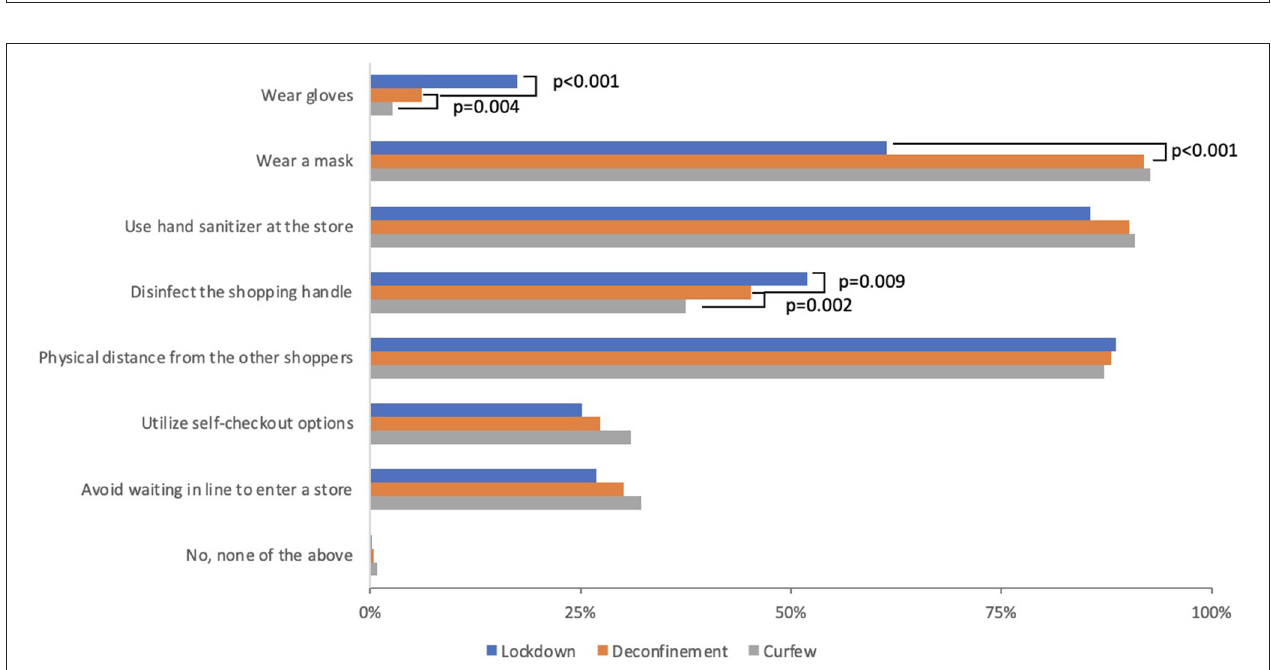
FIGURE 3 | Concerns over in-store grocery shopping. “Between (time period) , which of the following statements describes how you felt about possible exposure to the COVID-19 virus when in-store grocery shopping?” Wilcoxon signed-rank test: Lockdown vs. Deconfinement p < 0.001, Deconfinement vs. Curfew p = 0.239.